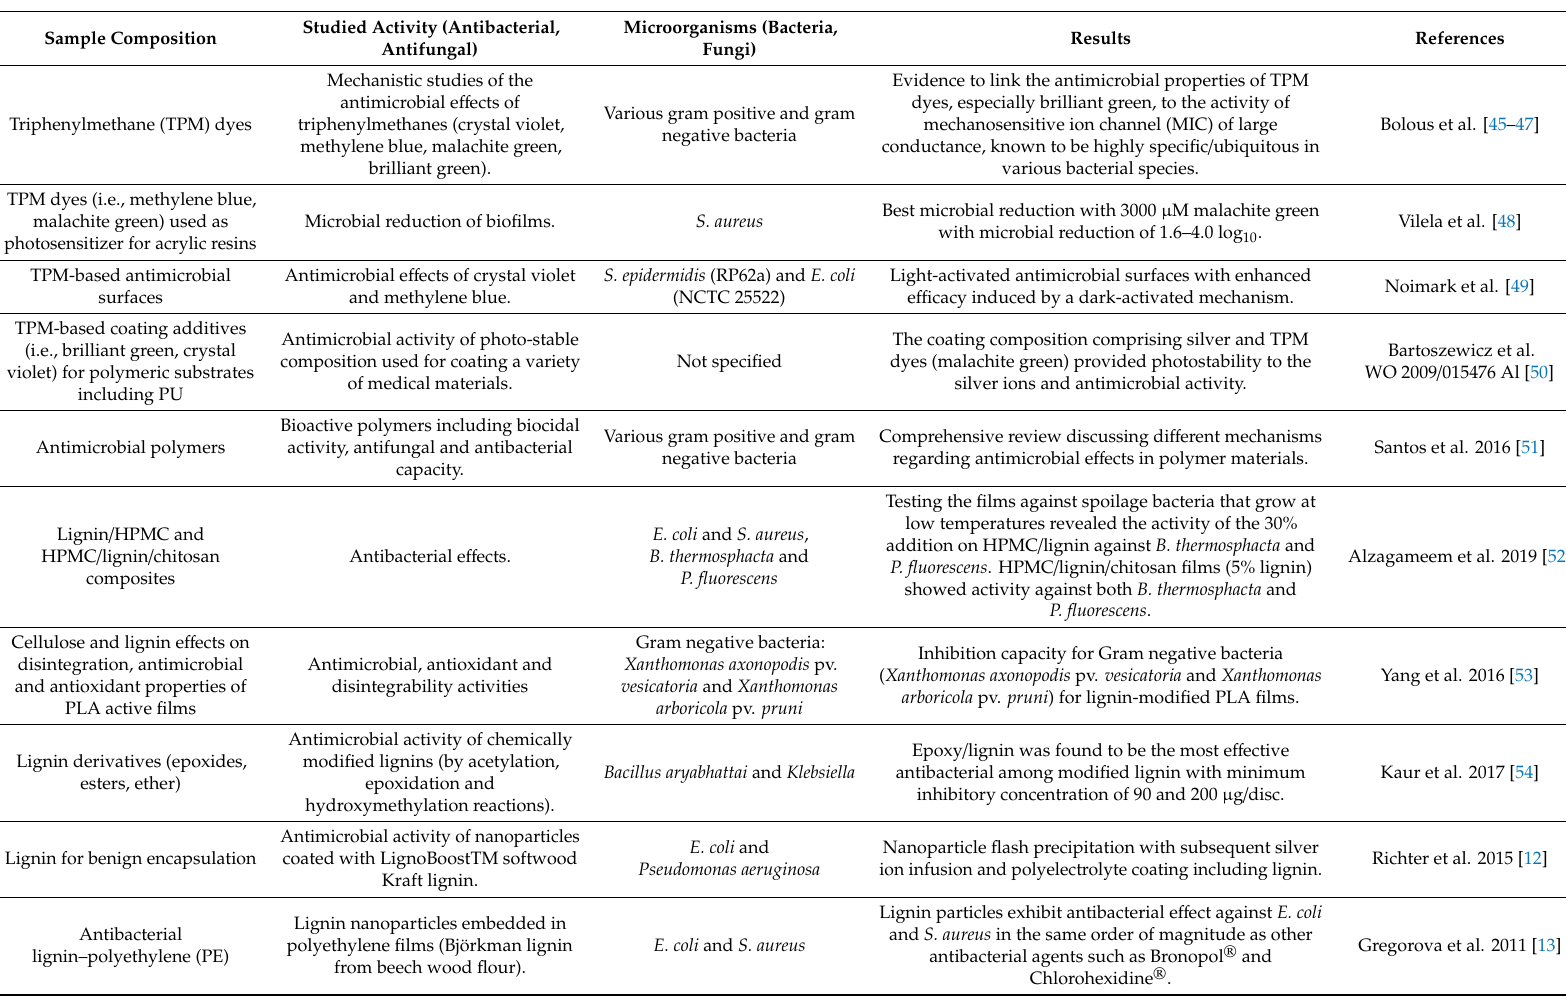
Table 1. Literature studies regarding antimicrobial activity of lignins and triphenylmethane derivatives (i.e., malachite green, brilliant green, methylene blue and crystal